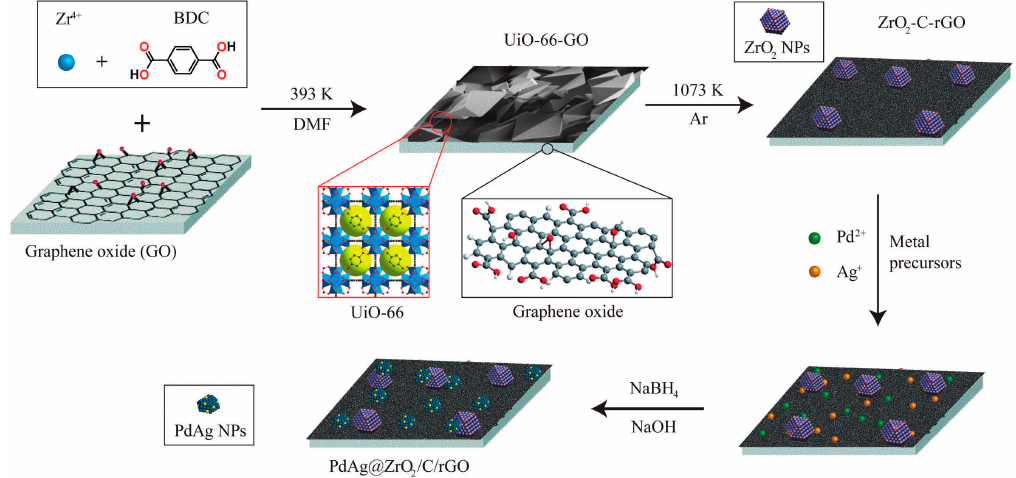
Figure 3. Schematic illustration for preparation of the PdAg@ZrO 2 / C / rGO nanocatalyst. Reprinted with Figure 4. Schematic illustration for preparation of the PdAg@ZrO 2 /C/rGO nanocatalyst. Reprinted permission from with permission from [32].